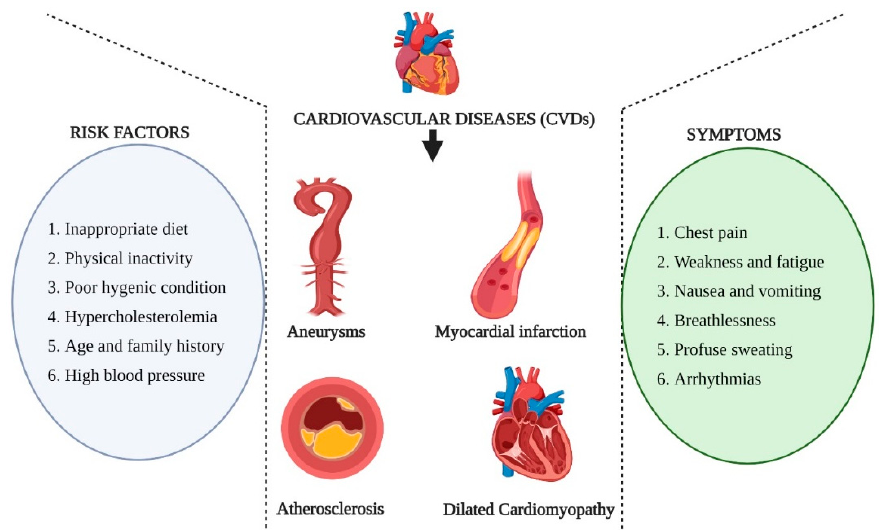
Figure 2. Schematic representation of different types of cardiovascular diseases (CVDs), the risk factors associated with the occurrence of CVDs and the common pathophysiological symptoms involved in CVDs.